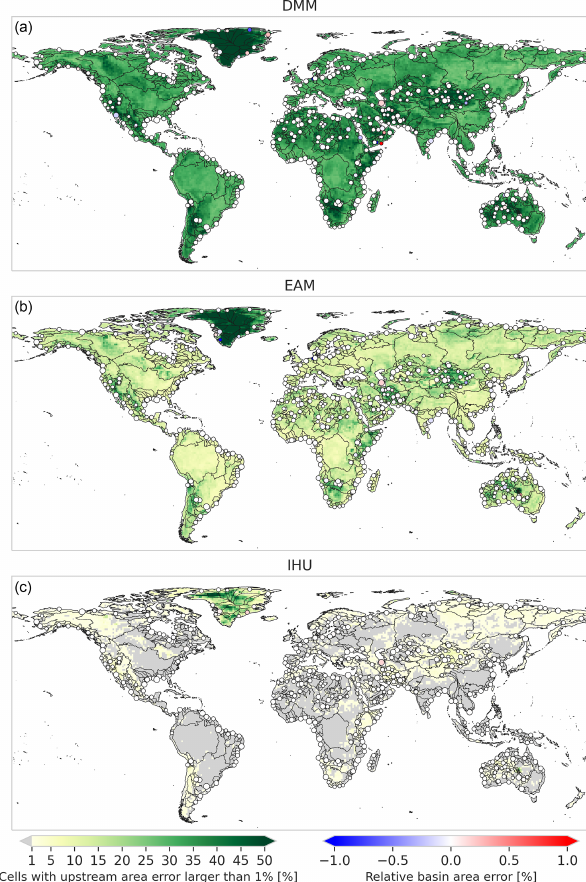
Figure D1. Percentage of cells at a 30arcsec ( ∼ 1km) resolution per 1 × 1 ◦ tile with an absolute relative upstream area error of more than 1%. The markers show the upstream area error at the basin outlet and the black lines the outlines of the 200 largest basins glob- ally.